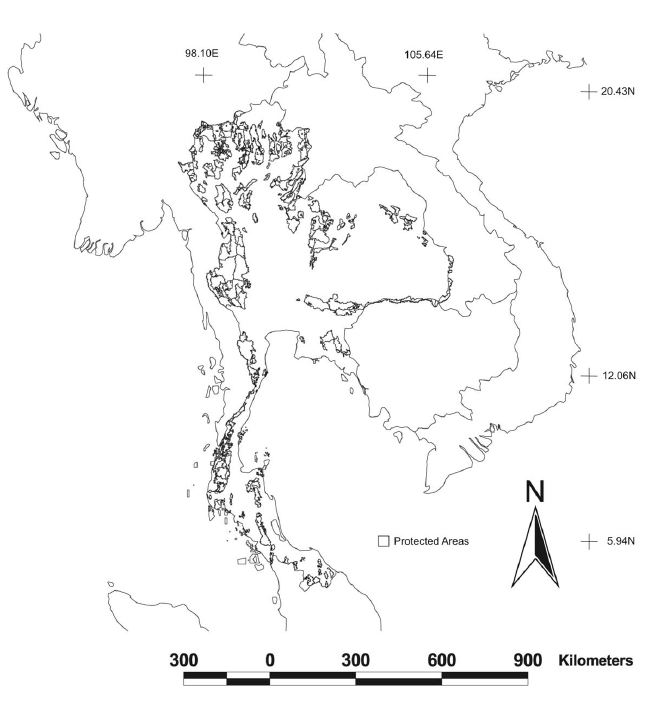
Figure 2. 187 protected areas (in 130 national parks and 57 wildlife sanctuaries) in